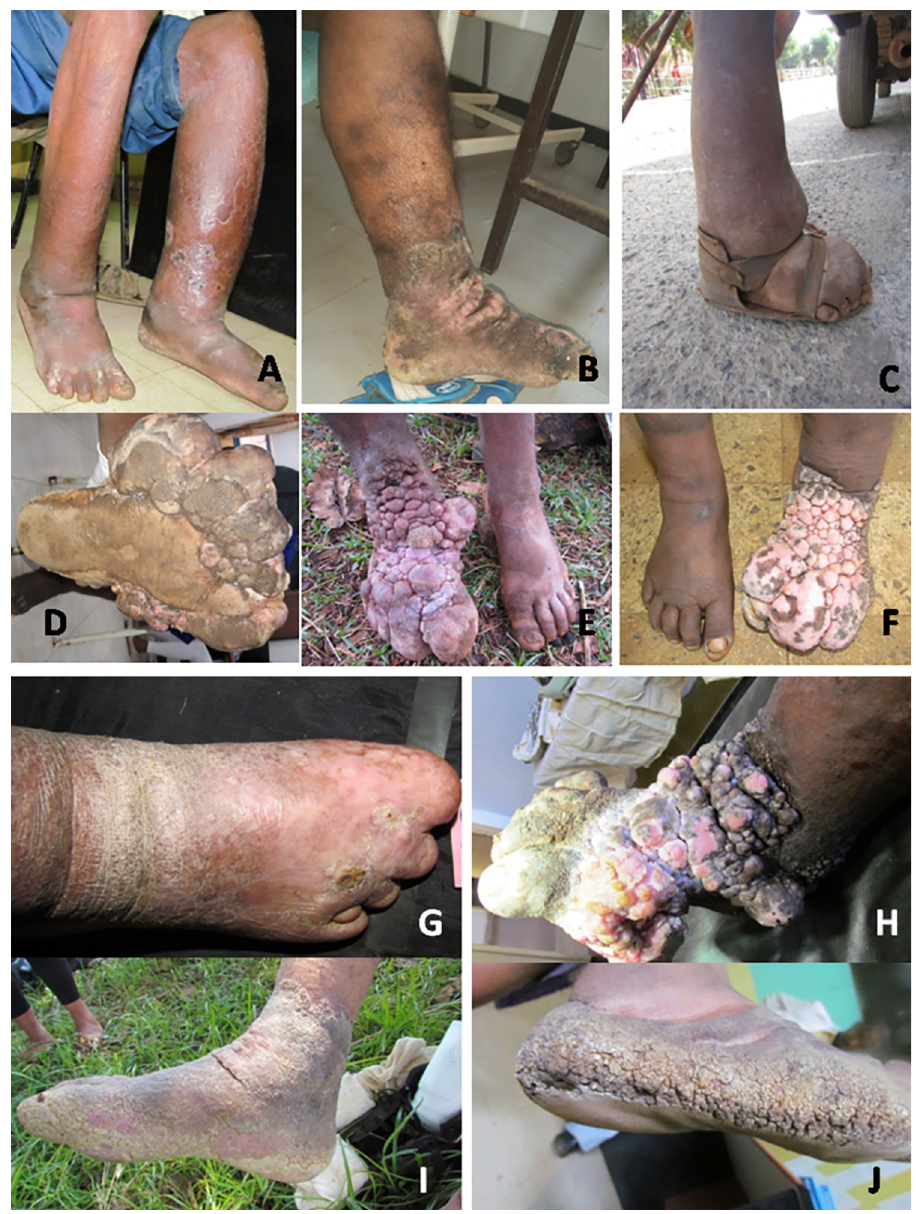
Fig 2. Clinical variations and complications of podoconiosis, in Durbete Podoconiosis Prevention and Treatment Centre, Durbete, Ethiopia, February 2018 to October 2019. A) Stage 2 podoconiosis patient with Acute Dermato- Lymph-Angitis (ADLA) presenting with pitting oedema of the left leg with epidermal exfoliation on the distal half of the lower leg. B) Stage 3 fibrotic oedema of the left leg below the knee with sclerotic hyperpigmentation and hypopigmentation accentuated on the shin and a fibrotic ridge on the flexural ankle. C) Stage 2: Water-bag type oedema with pitting and soft swelling and a flask-like appearance with the neck around the knee and wider base on the ankle and oedematous foot with a smooth and dumpy surface around the shoe strap areas. D) Stage 3 podoconiosis, multiple nodules with plantar foot involvement. E) Asymmetric podoconiosis with right leg stage 3 diseases with fibrotic depigmented nodules on foot and above the ankle, while the left leg is not affected. F) Asymmetric lymphoedema with the right leg in stage1, and the left leg in stage 3 podoconiosis with depigmented nodules and toe fusion. G) Stage 5: oedematous right foot with scarring of the distal half of the dorsum of the foot, bone resorption of all the toes. H) Stage 3 podoconiosis with multiple coalescent nodules on the dorsum of the foot extending to the sole of the foot and above the ankle with maceration and oozing. I) Fibrotic lymphoedema of the right leg with a continuous sock-like yellowish crust covering the whole foot and lower leg, and band like skin invagination on the flexural ankle joint. J) Hyperpigmented warty papules coalescing and covering the lateral feet and cracking in moccasin-like configuration.